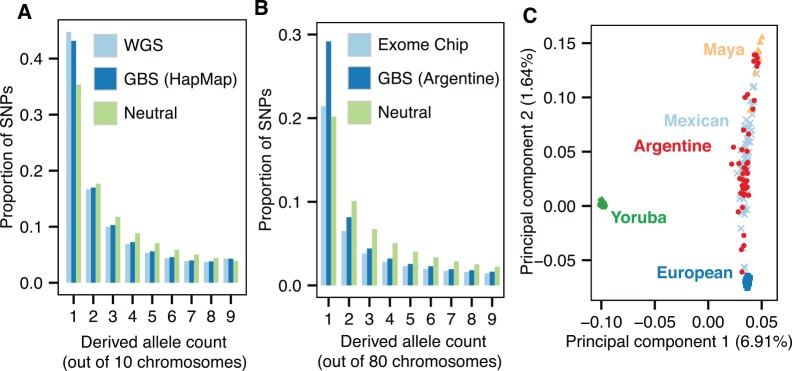
Detecting population structure and growth with GBS data.A. Normalized site frequency spectra (SFS) of the derived allele for six HapMap samples represented as the expected SFS of a subsample of size five to account for missing data. SNPs from the 29.2 Mb region that passed all filters were used for both GBS and whole-genome sequencing (WGS) spectra. The expected SFS under a neutral coalescent model is shown for comparison. B. Bins 1–9 of the normalized SFS for SNPs in the Argentine GBS data set, represented as the expected SFS of a subsample of size 40. Exome chip data was from 386 Argentine individuals, including some of those sequenced by GBS. C. Principal components 1 and 2 of the admixed Argentine individuals, Europeans (CEU), Yoruba (YRI), Mexican (MXL), and Maya (HGDP), using 30,691 SNPs. Of the Argentine samples, 40/63 passed the 5% data missingness filter and were used in the PCA.